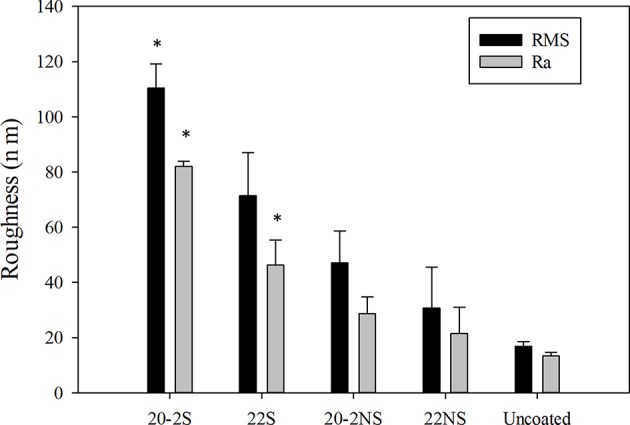
Surface roughness of PDA-coated meshes and uncoated PP mesh determined using AFM. Root mean squared roughness (RMS) and average roughness (Ra) values were reported for the 10 × 10 μm2 images. Data are shown as mean ± standard deviation of three independent measurements. *p < 0.05 when compared to other samples including uncoated and PDA-coated.